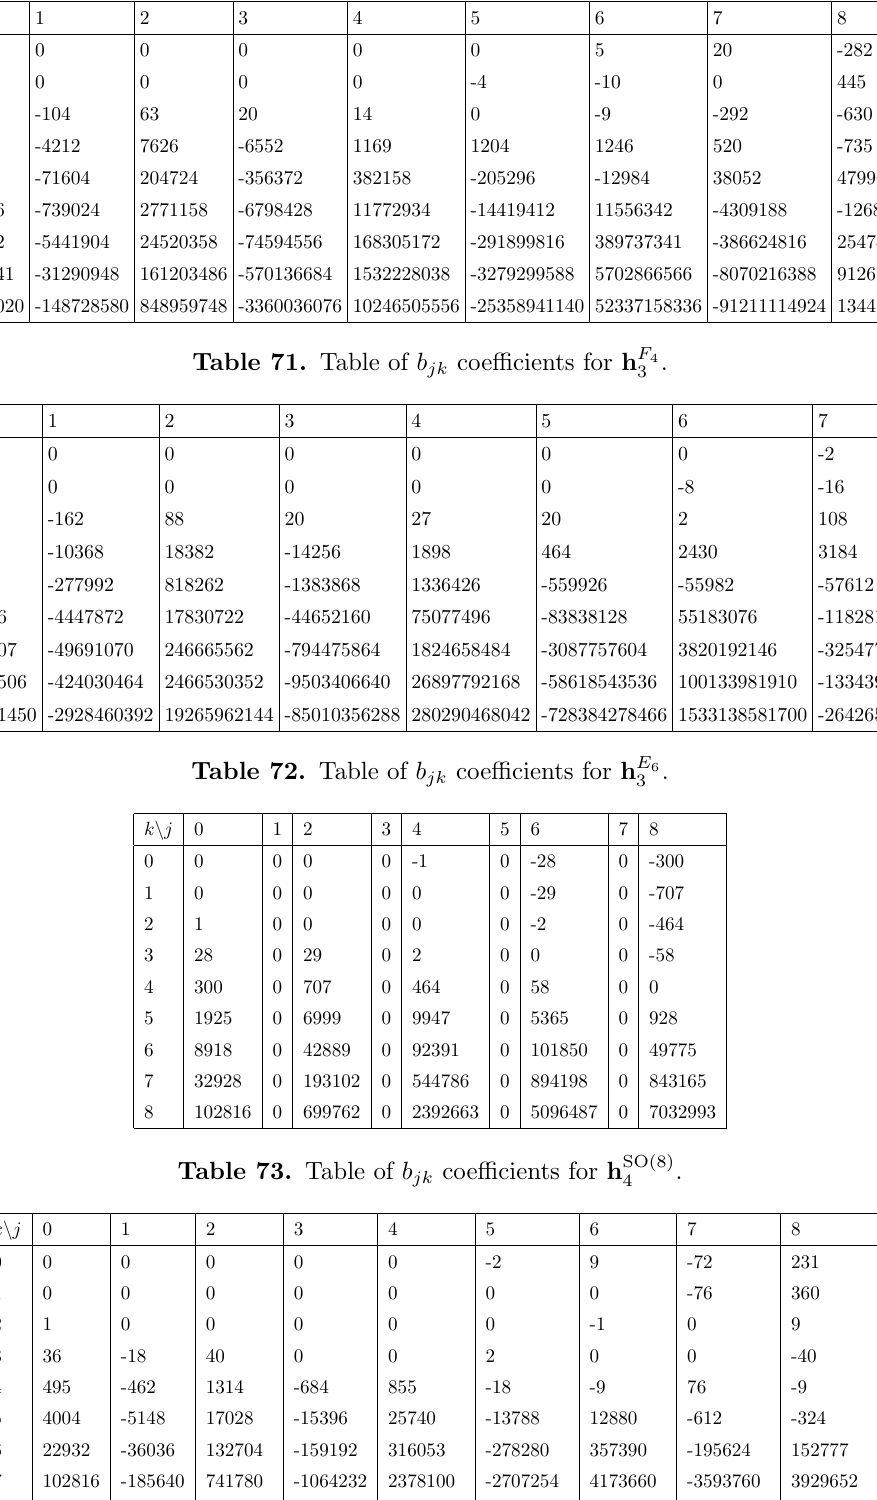
Table 74. Table of b jk coe(cid:14)cients for h SO(9)